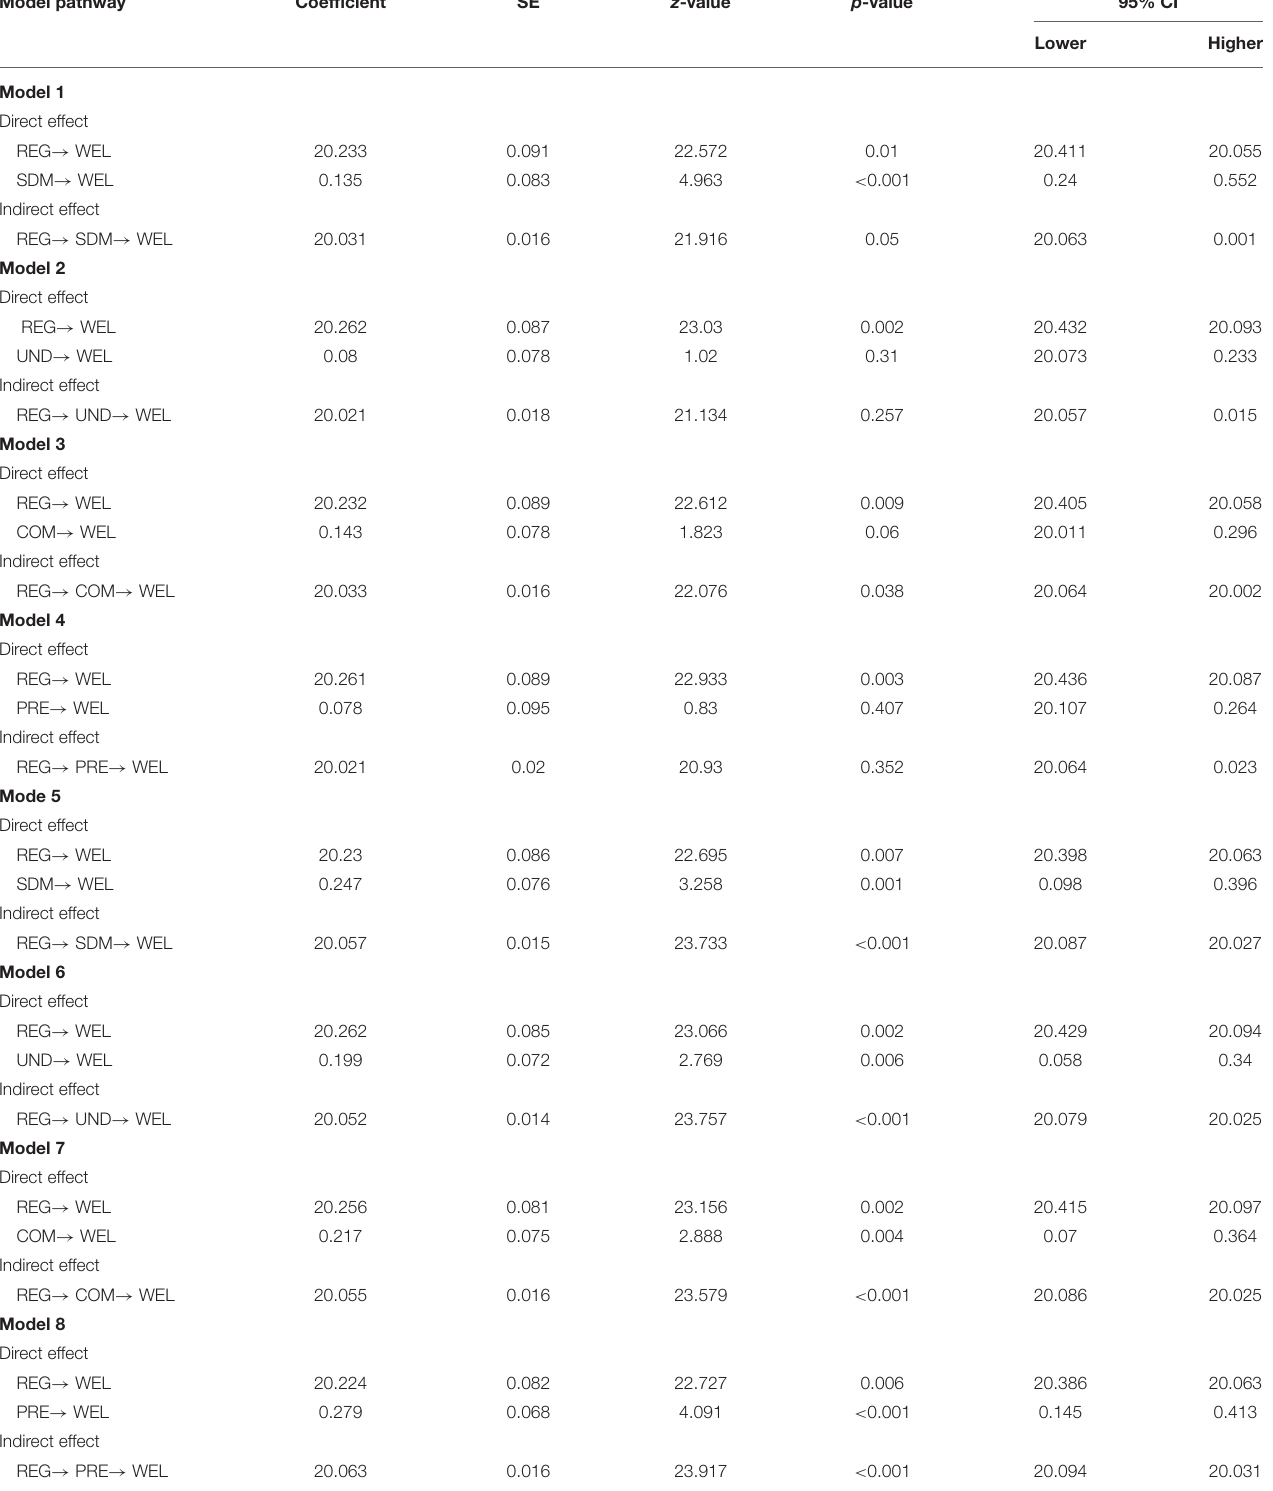
TABLE 3 | Direct and indirect effects and 95% confidence intervals for the models. Model pathway Coefficient SE z -value p -value 95% CI